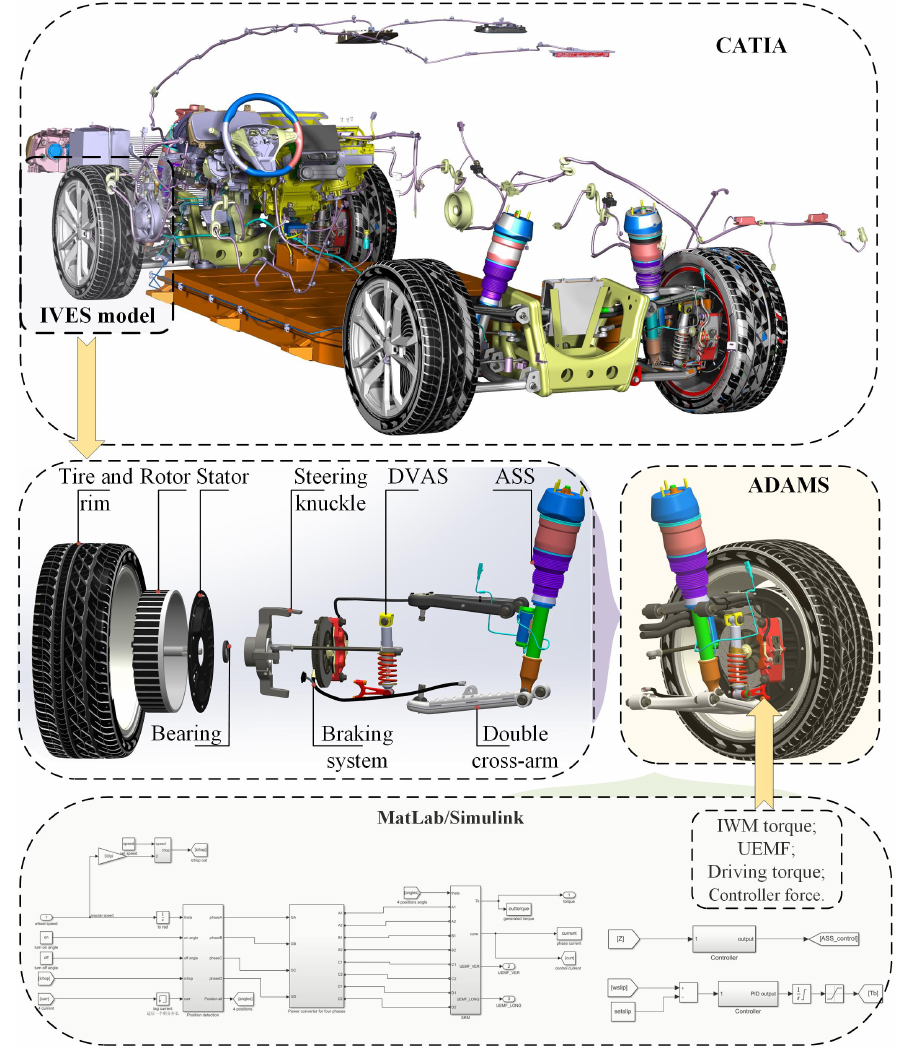
Figure 12. The VP building